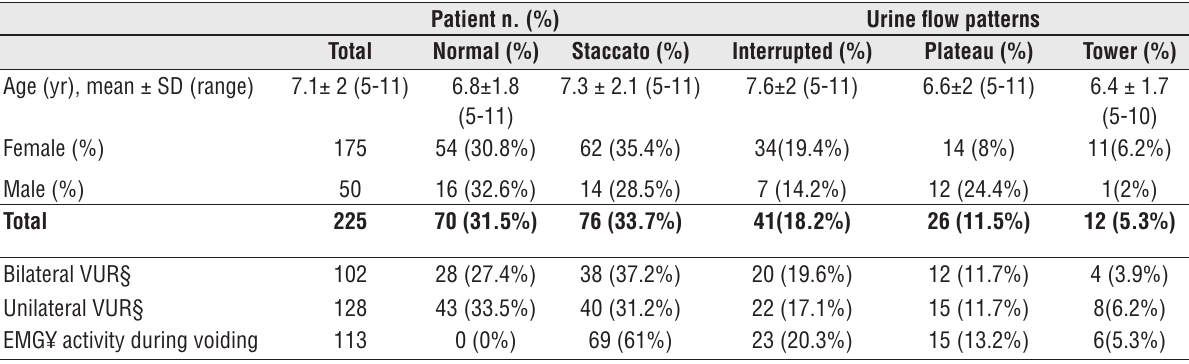
Table 1 - Characteristics and urine flow patterns of all patients.